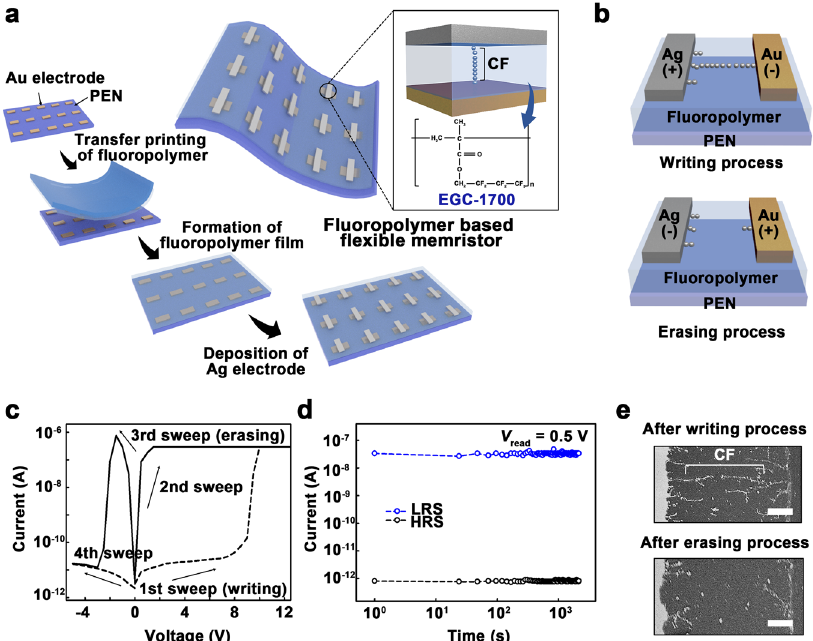
Fig. 1 Concepts and operating principles of the fl uoropolymer-based fl exible memristor. a Schematics of the fabrication process of the fl exible memristors based on the fl uoropolymer. Inset image shows the device con fi guration and the chemical structure of the fl uoropolymer. b Schematics illustrating the fl uoropolymer-based memristor with a lateral structure. The gap between the electrodes was about 4.8 μ m. c Current – voltage curves of the lateral-type device. d Retention characteristics of the lateral-type device. e Active surfaces of the lateral-type device after the writing and erasing processes, observed by fi eld emission scanning electron microscopy (scale bar, 1 μ